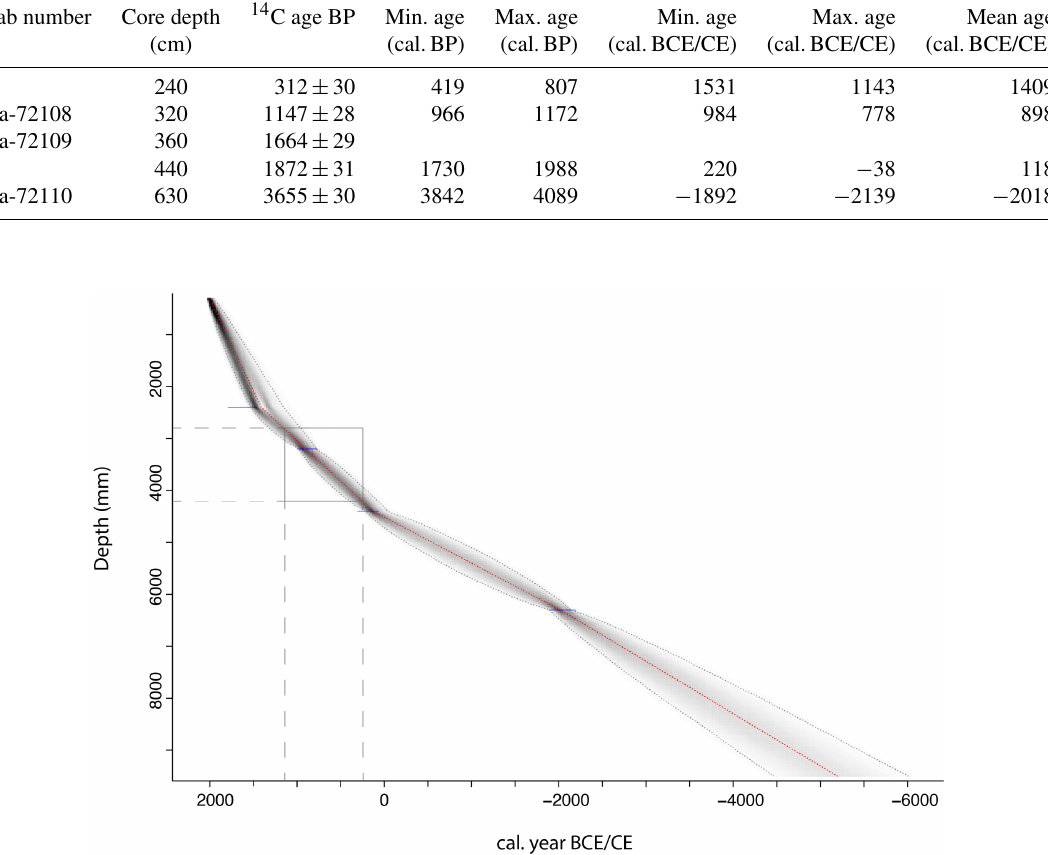
Figure A8. Age–depth model for the Åsheimmyr peat sequence represented with the RBacon package. The section in the rectangle indicates the study period